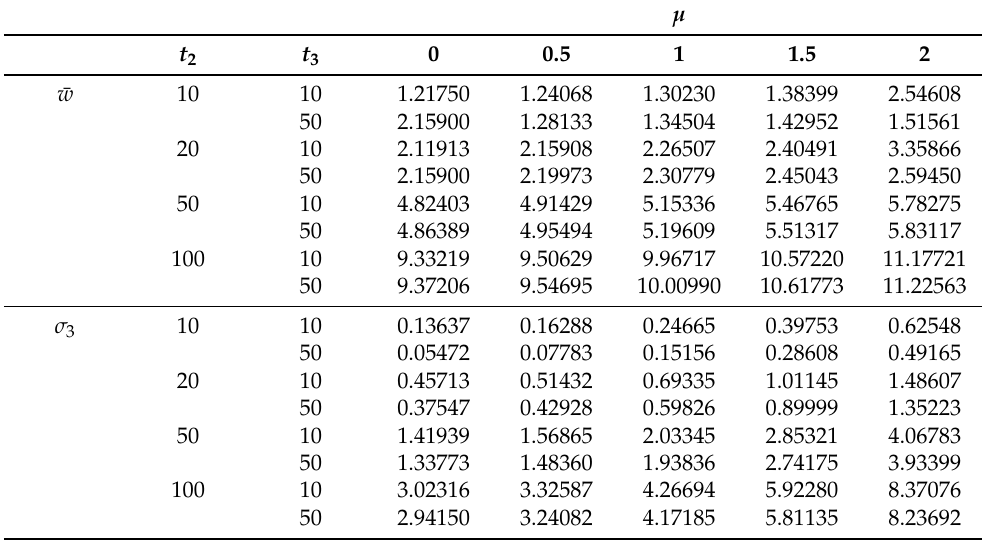
Table 8. Effects of the nonlocal coefficient and thermal parameters on the deflection ¯ w of and transverse normal stress σ 3 in the FG square nanoplate embedded in an elastic medium ( κ 1 = κ 2 = 10, a / h = 10, β =